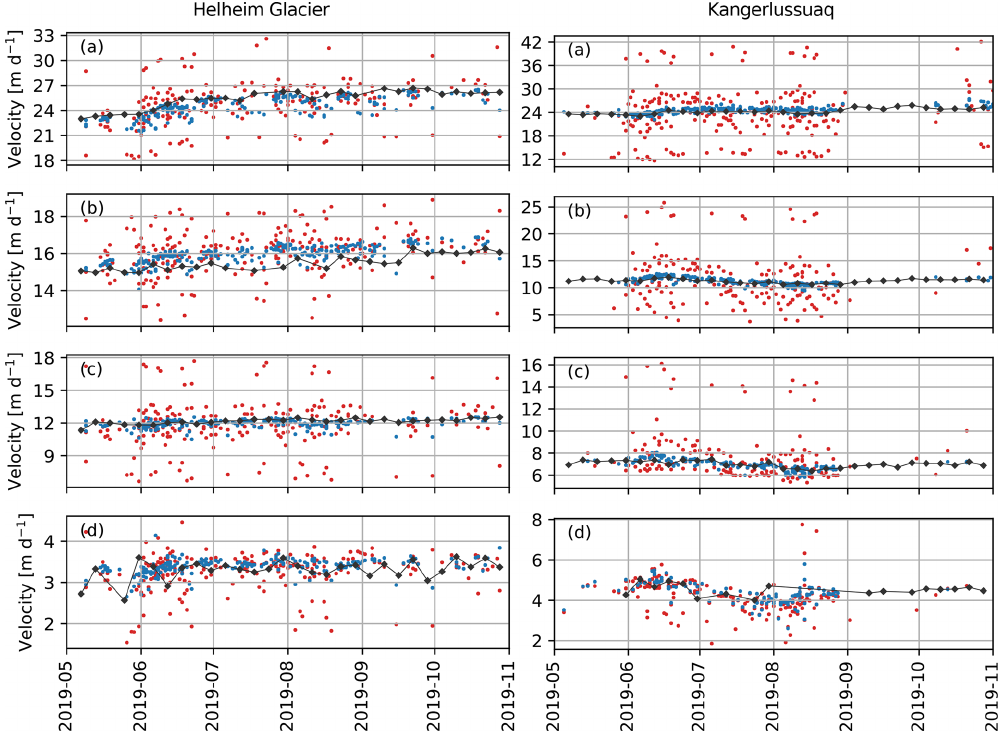
Figure 6. Corrected (blue) and uncorrected (red) velocity time series for four sample glaciers in 2019. Top to bottom are points (a–d) in Fig. 1. The black line and diamonds mark the MEaSUREs Sentinel-1 velocity dataset for